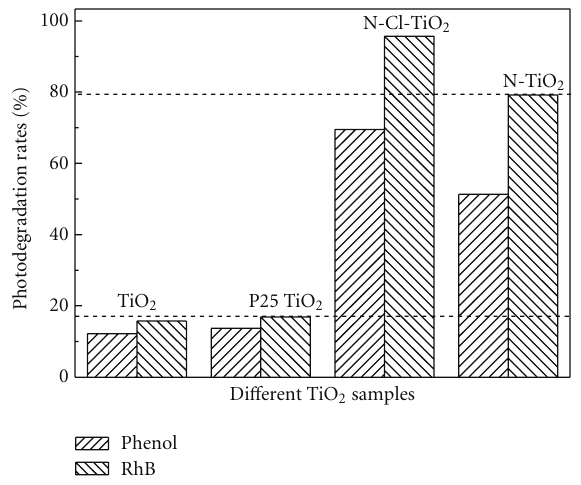
Figure 6: Photocatalytic degradation rates of RhB and phenol on di ff erent TiO 2